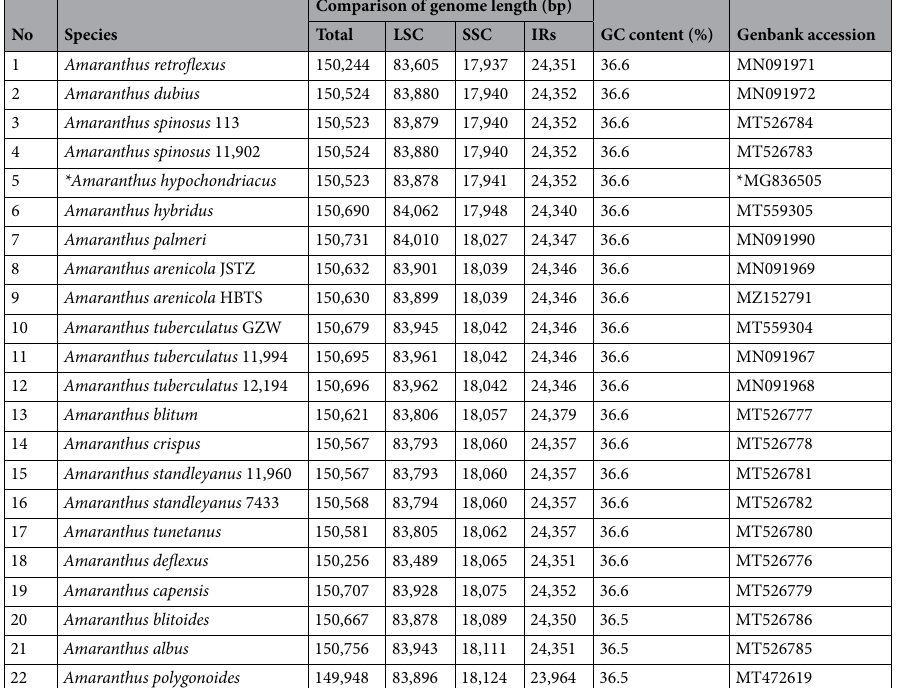
Table 1. Summary information for the chloroplast genomes of Amaranthus. *Chloroplast genomic data for Amaranthus hypochondriacus were obtained from GenBank.